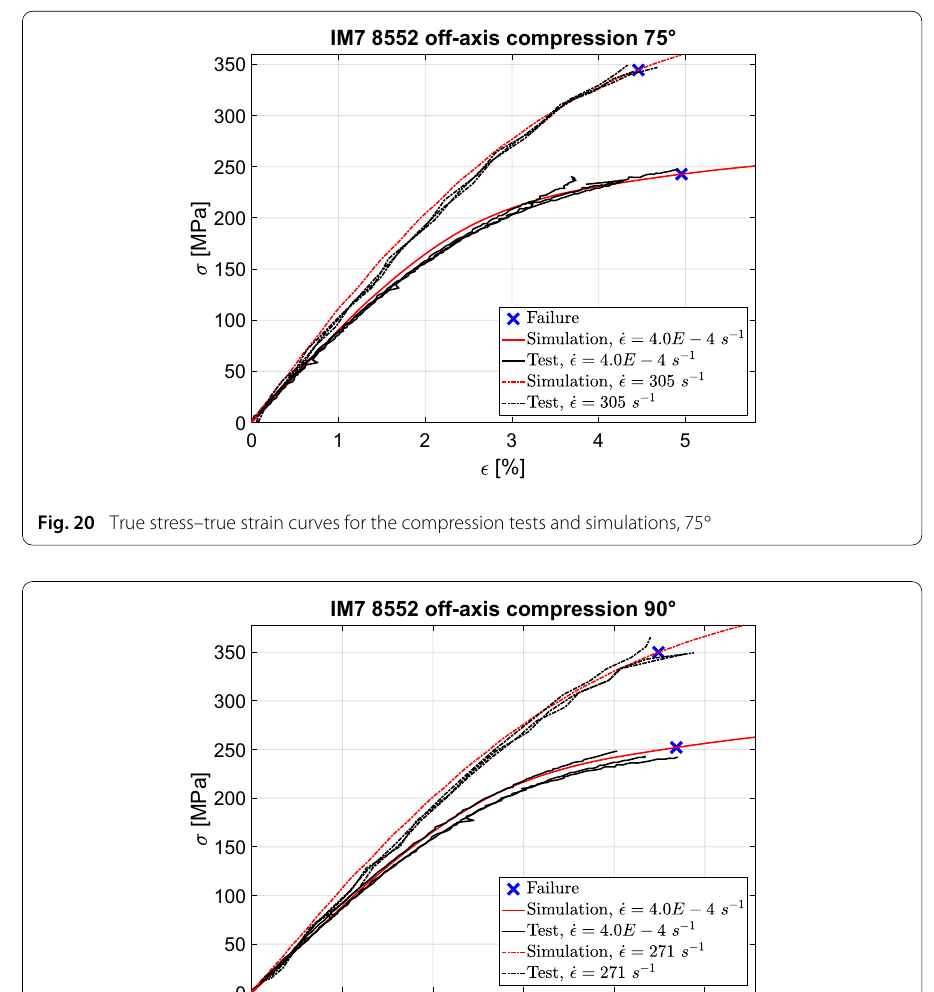
the available off-axis tension and compression test data and the influence of triaxiality on thein-planeshearcharacterizationwasdiscussed.Thecalibrationoftheparameter η ofthe presented viscoplastic model was shown, assuming an approximated linear dependency of the yield stress on the logarithmic strain rate, since experimental data was available from only two strain rate regimes. The strain rate dependency of the elastic moduli and the ultimate strength properties was introduced in the proposed model by fitting the available experimental data with suitable scaling functions. For the prediction of failure, an Invariant based Quadratic failure Criterion (IQC) based on the work of Vogler et